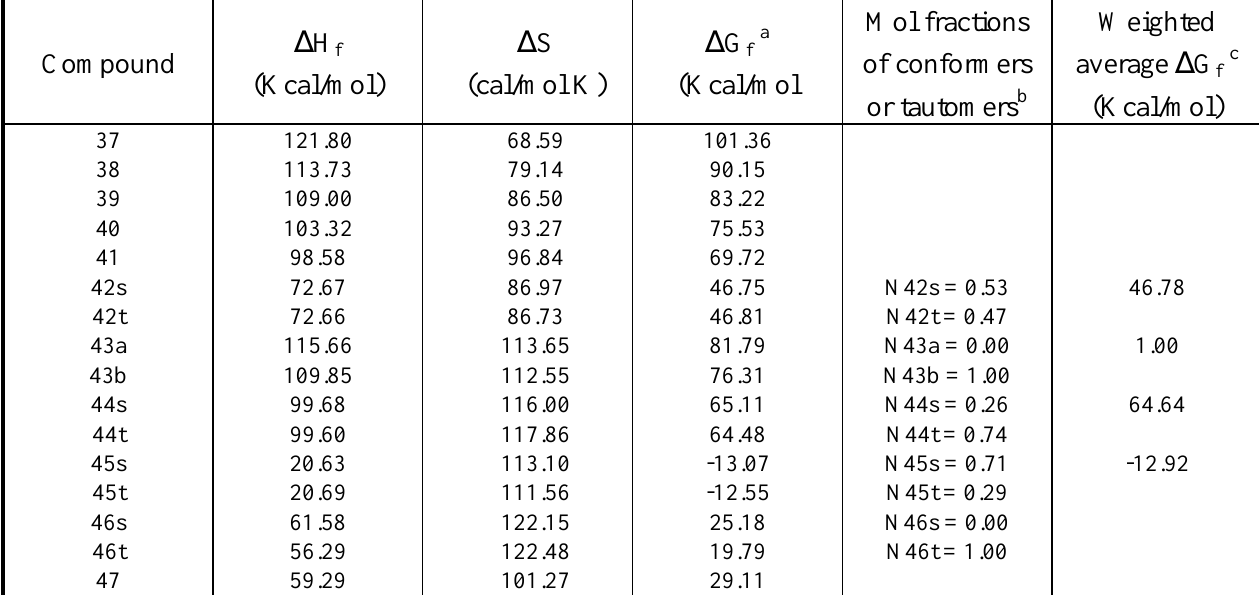
Table 5 . The PM5 calculated thermodynamic properties of protonated pyridine derivatives in aqueous solution ( e